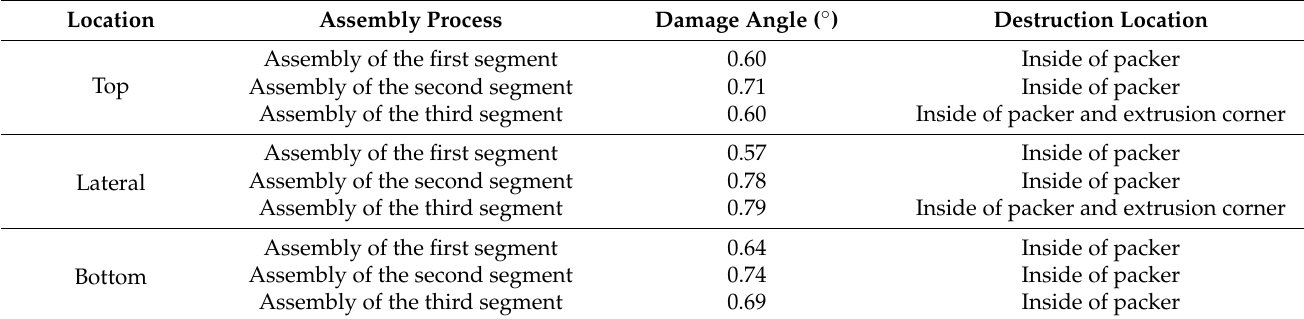
Figure 13. Damage to a segment in the presence of inward deflection when the asymmetric error angle is 1°: ( a ) first segment assembly (%); ( b ) second segment assembly (%); ( c ) third segment as- sembly (%). (Take the segment at the top as an example.) Table 4. Damage to the segments. Table 4. Damage to the segments.